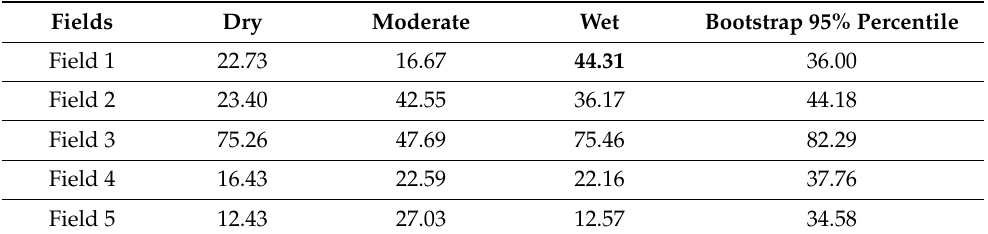
Table 3. Consistency index in different climate years based on in-crop rainfall (ICR). Bold values indicate marginally significant adjusted p values ( p <